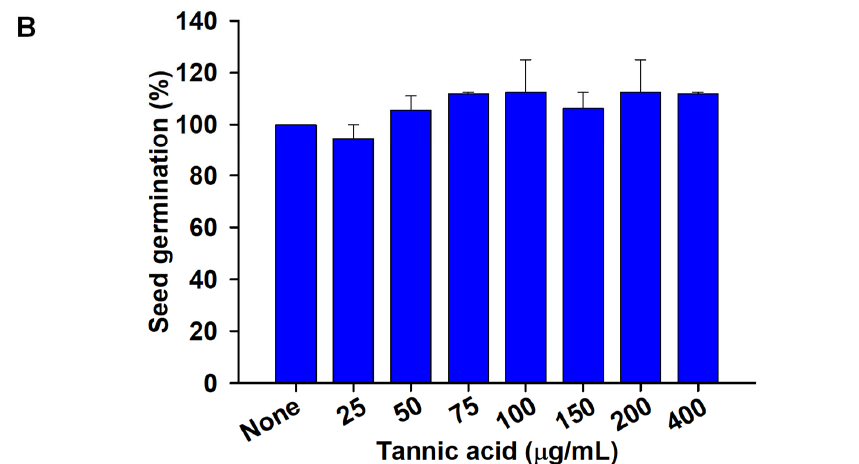
Figure 8. Toxicity assessment of tannic acid on R. sativus seed germination over 5 days on tannic acid infused into 0.7% agar and 0.86 g/L MS medium ( A ). Bar plot of percentage seed germination as a function of increasing tannic acid concentration ( B ). Seeds ( n = 10) were used for each concentration, and experiment was repeated twice.